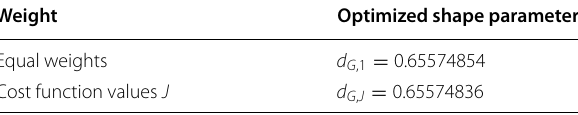
Table 3 Optimal Shape Parameter with Different Weights